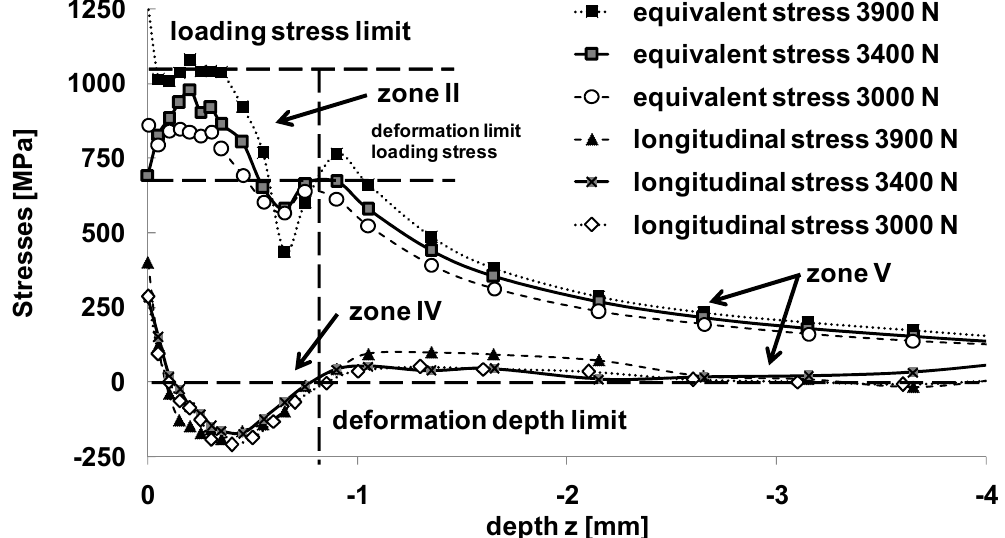
Figure 6. Graph of loading equivalent stresses σ eq under contact point at y = 0 mm and the resulting residual stress of the σ yy component at y = − 4.15 mm over depth for three applied contact forces.